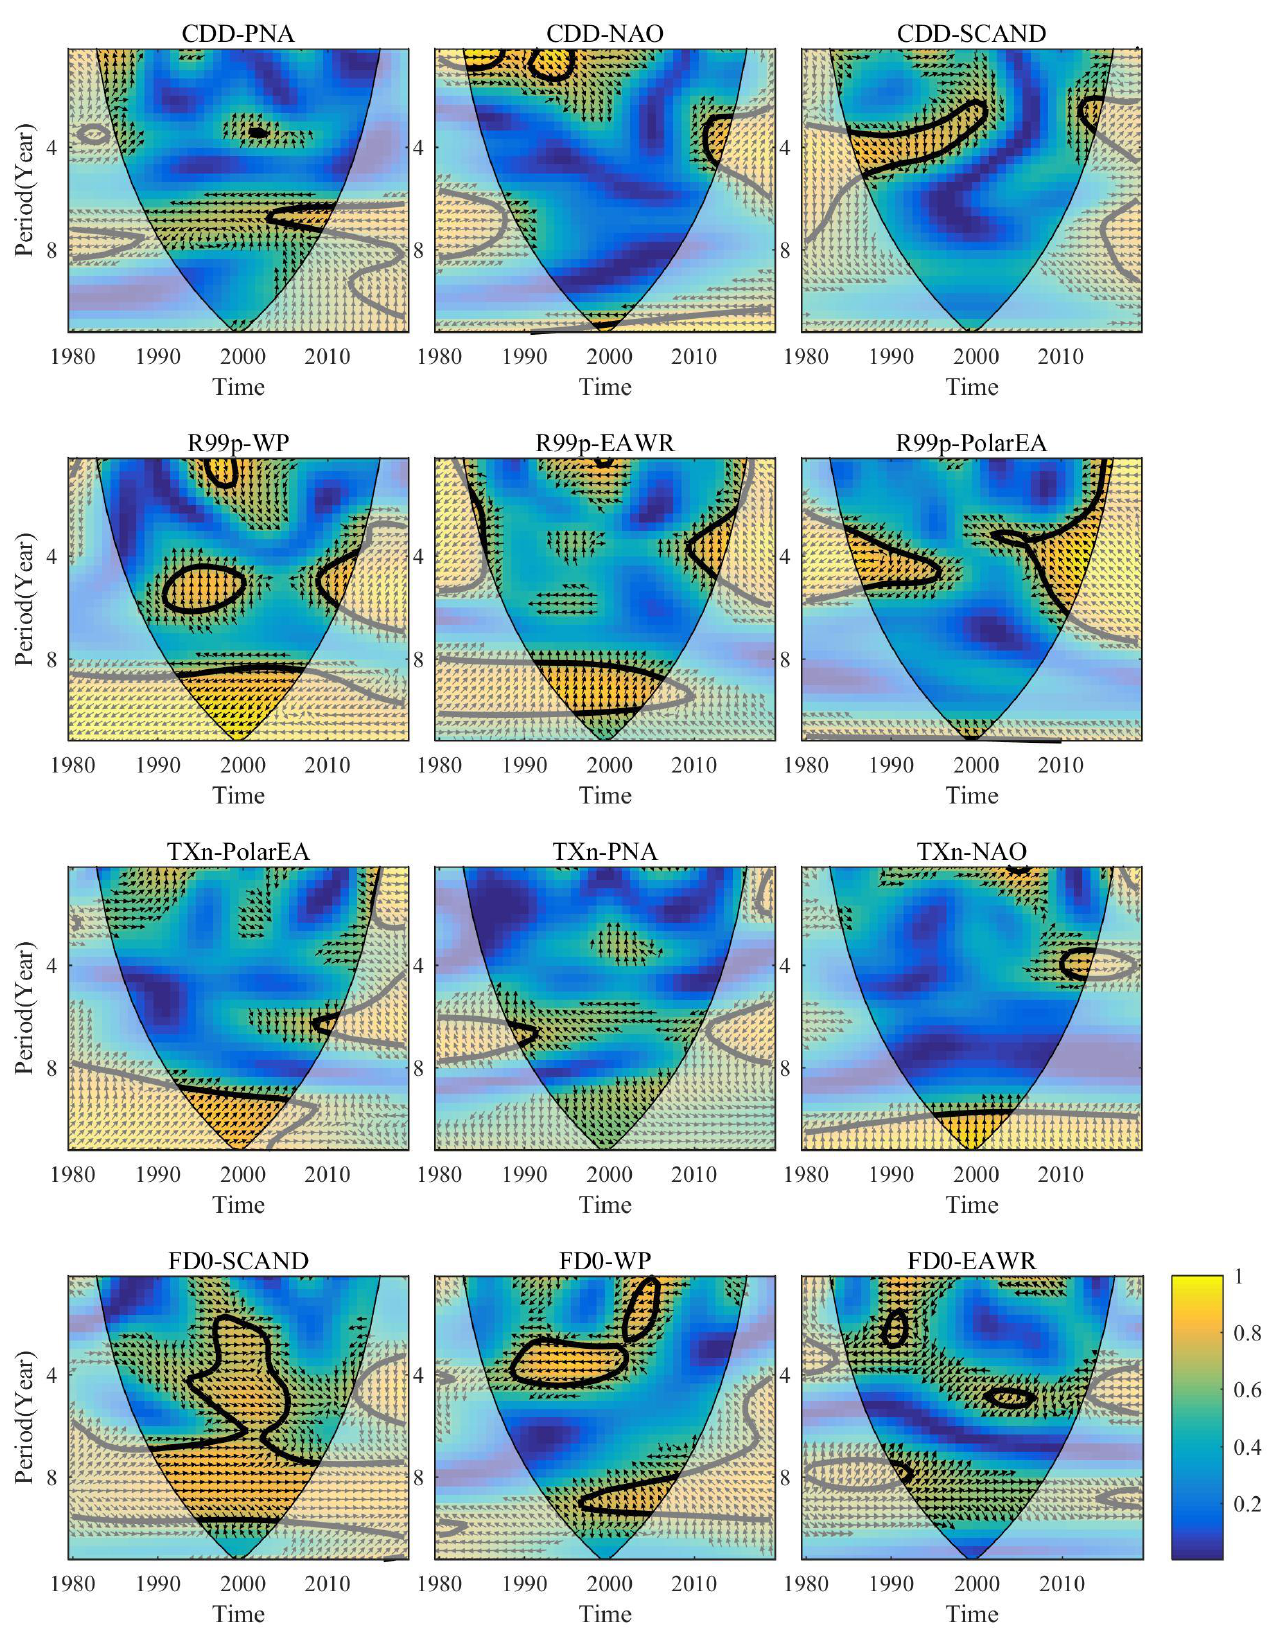
Figure 9. The WTC between extreme climate indices and teleconnection patterns in the Beijing – Tianjin – Hebei region.